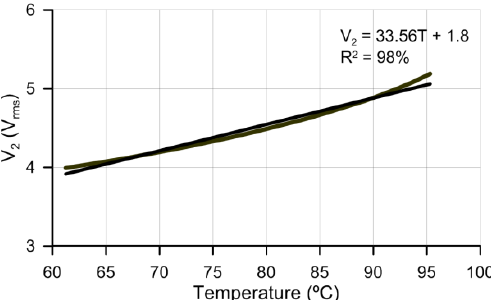
Figure 9. Voltage versus temperature in a range from 60 °C to 95 °C and 50 V voltage. Linear fit with a 33.5 mV/°C